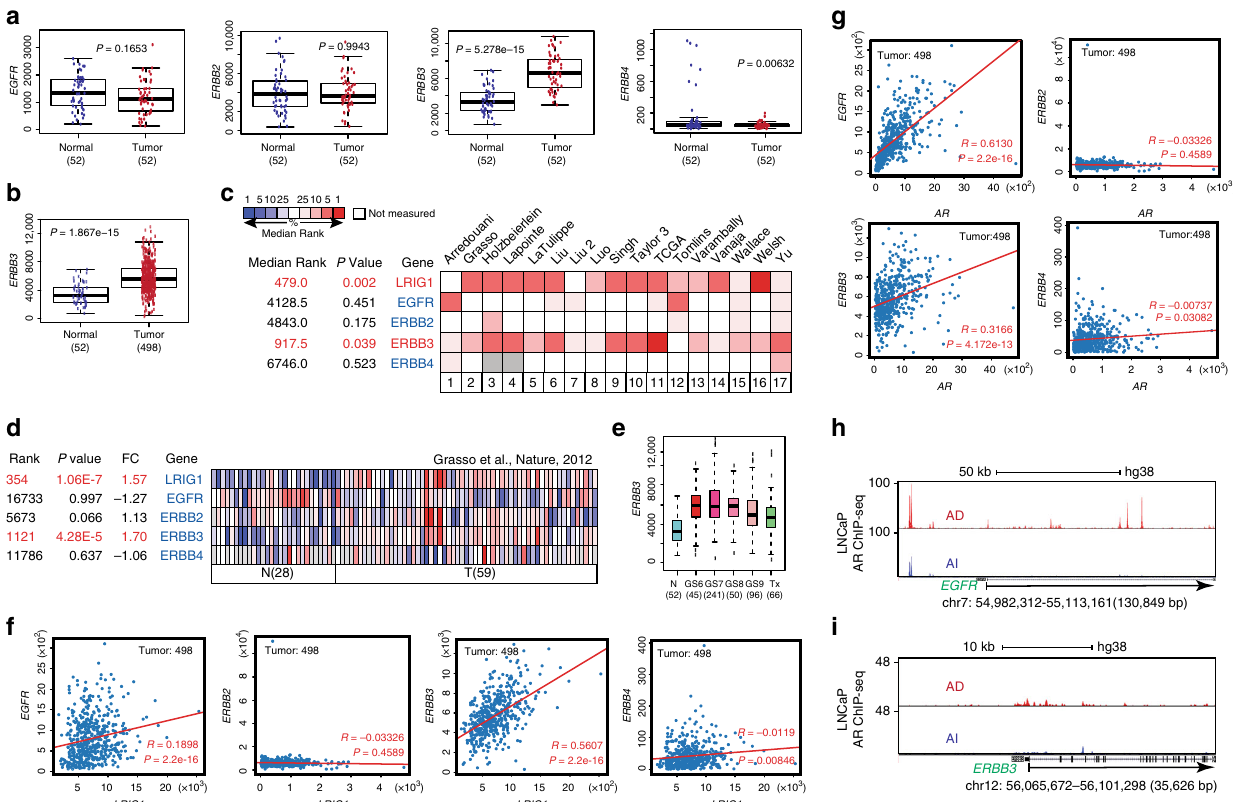
Fig. 8 Interrelationship between LRIG1, ERBBs and AR in PCa. a Increased ERBB3 and low expression of ERBB4 mRNA levels in PCa. Shown are box plots of the mRNA levels (normalized RSEM) of 4 ERBBs in 52 matched normal vs. tumors in TCGA PRAD dataset. P -values are indicated (two-tailed unpaired Student ’ s t -test). b Increased ERBB3 mRNA in 498 prostate tumors compared with 52 normal tissues in TCGA PRAD dataset. P -value was calculated using two-tailed unpaired Student ’ s t -test. c , d Co-upregulation of LRIG1 and ERBB3 mRNA levels in 17 Oncomine PCa datasets ( c ) and Grasso dataset ( d ). e The ERBB3 mRNA expression pattern resembles that of LRIG1 in TCGA PRAD dataset (see Supplementary Fig. 13a). Note that ERBB3 mRNA levels are signi fi cantly higher in GS6 tumors than in normal (N) tissues ( P < 0.0001; Student ’ s t -test) but then decreased with increasing Gleason grade ( P < 0.001; Jonckheere-Terpstra test). f Only ERBB3 mRNA levels correlate with LRIG1 mRNA levels in TCGA PRAD dataset, as determined by linear regression analysis (R and P values indicated). g Positive correlations between AR and EGFR , and, less signi fi cantly, between AR and ERBB3 mRNA levels. mRNA levels of AR and 4 ERBB genes were downloaded from TCGA 498 prostate tumors and used to construct Pearson correlation linear regression plots (R and P values indicated). h Potential AR binding to EGFR gene. Shown is the AR ChIP-seq binding pro fi le in LNCaP AD (top; GSM699631) vs. AI (bottom; GSM699630) cells. Note that EGFR gene has a very long intron 1 (>100 kb) between the fi rst and second exons and therefore, only AR-binding pro fi le in the fi rst exon was shown. Several prominent AR binding peaks are observed in the fi rst exon of the EGFR gene in AD cells that are all lost in AI cells. i Potential AR binding to ERBB3 gene. AR binding peaks were extracted from the same AR ChIP-seq data in AD (top) and AI (bottom) LNCaP cells shown above. Also see Supplementary Fig. 15f. For box plots in a , b , and e , the centerlines represent the medians, box edges 25th and 75th percentiles, and whiskers the maximum and minimum